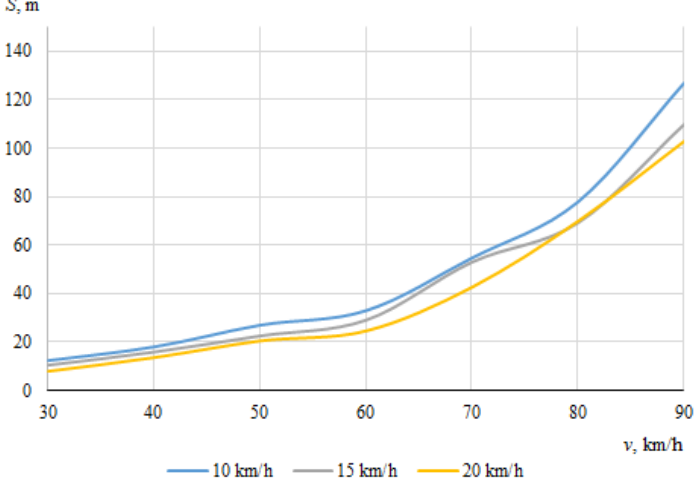
Figure 19. Throwing distances of the cyclist (impact angle 90°).